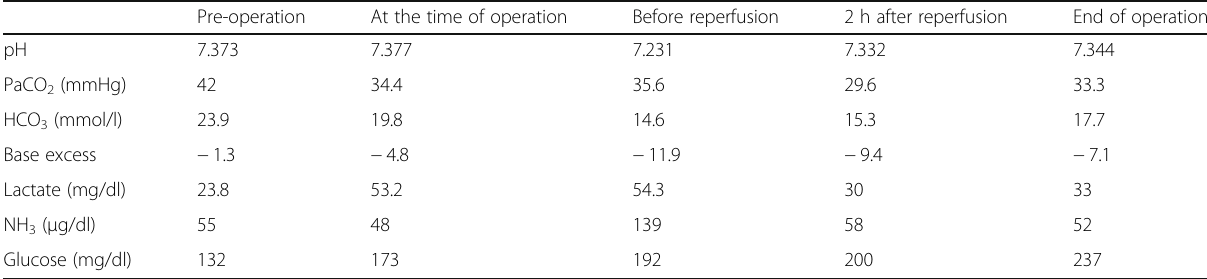
Table 1 Preoperative and intraoperative arterial blood gas data. Normal range of ammonia (NH 3 ) is 20 – 60 μ g/dl